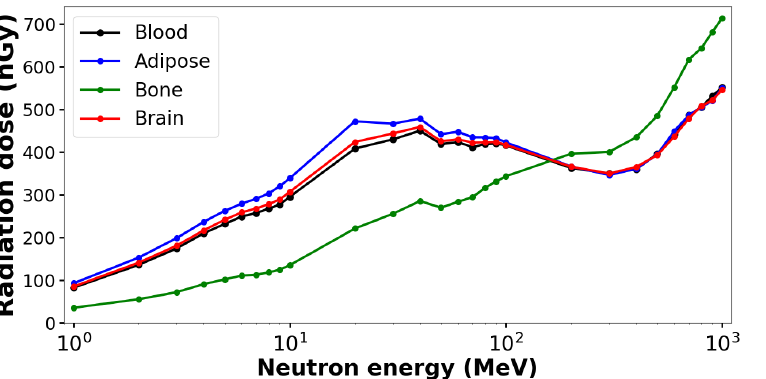
Figure 3. Radiation dose deposited by 5 × 10 5 neutrons to each energy in the tissue samples. This result was obtained by a numerical